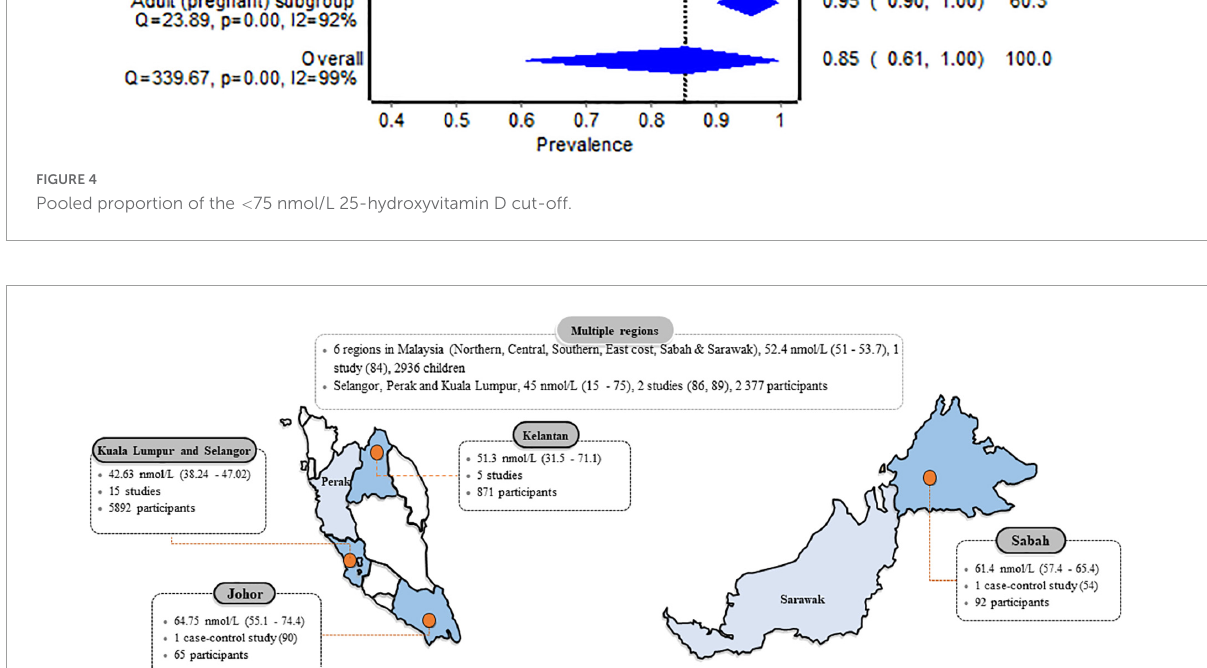
FIGURE5 Mean 25-hydroxyvitamin D [25(OH)D] concentrations in Malaysia according to states. Data are the mean (95% confidence interval) of 25(OH)D concentrations reported in studies done in each state. The 25(OH)D mean values were pooled if there were more than one study from a form and were computed only from studies that stated the mean (SD), or median and interquartile range or range.